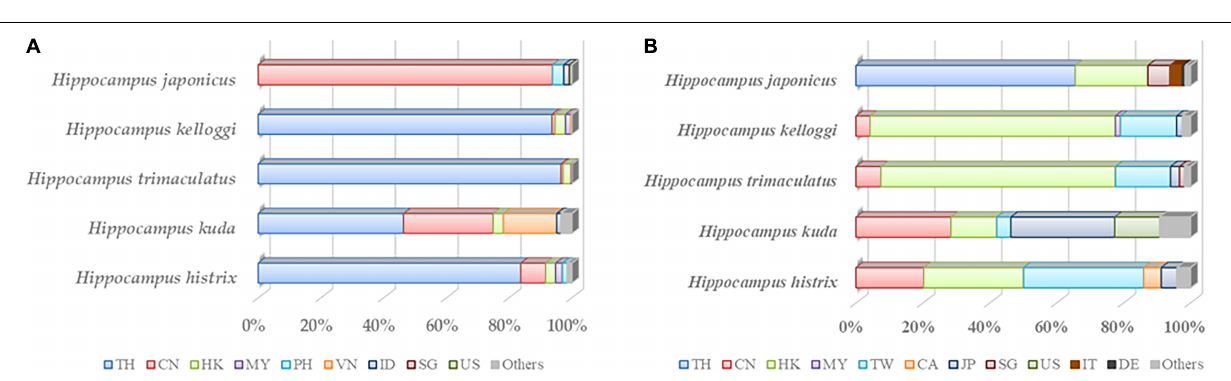
FIGURE 3 | (A) In five medicinal Hippocampus , the export volume of the top five countries and regions accounted for proportion of total export volume in 2000–2020. (B) In five medicinal Hippocampus , the import volume of the top five countries and regions accounted for proportion of total import volume in 2000–2020. TH, Thailand; CN, China; HK, Hong Kong (China); MY, Malaysia; PH, Philippines; VN, Vietnam; ID, Indonesia; SG, Singapore; US, United States of America; TW, Taiwan Province of China; CA, Canada; JP, Japan; IT, Italy; DE, Germany; Others, other countries and